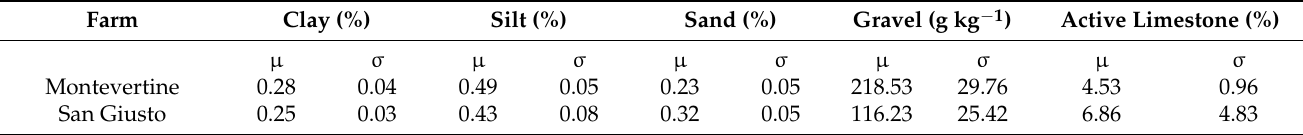
Table 2. Average values ( µ ) and standard deviation ( σ ) of the particles size composition (percentage of clay, silt and sand), gravel and percentage of active limestone of Azienda Agricola Montevertine (MV) and Fattoria San Giusto a Rentennano